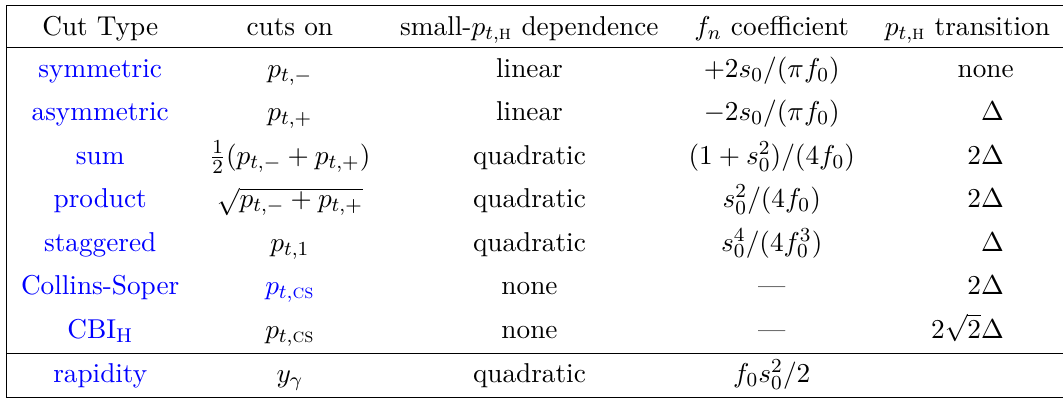
Table 1 . Summary of the main hardness cuts, the variable they cut on at small p t, h , and the small- p t, h dependence of the acceptance. For linear cuts f n ≡ f 1 multiplies p t, h /m h , while for quadratic cuts f n ≡ f 2 multiplies ( p t, h /m h ) 2 (in all cases there are additional higher order terms that are not shown). For a leading threshold of p t, cut , s 0 = 2 p t, cut /m h and f 0 = for the rapidity cut s 0 = 1 / cosh( y h − y cut ) . For a cut on the softer lepton’s transverse momentum of p t, − > p t, cut − ∆ , the right-most column indicates the p t, h value at which the p t, − cut starts to modify the behaviour of the acceptance (additional O interplay between hardness and rapidity cuts, see sections 4.2, 4.3 and